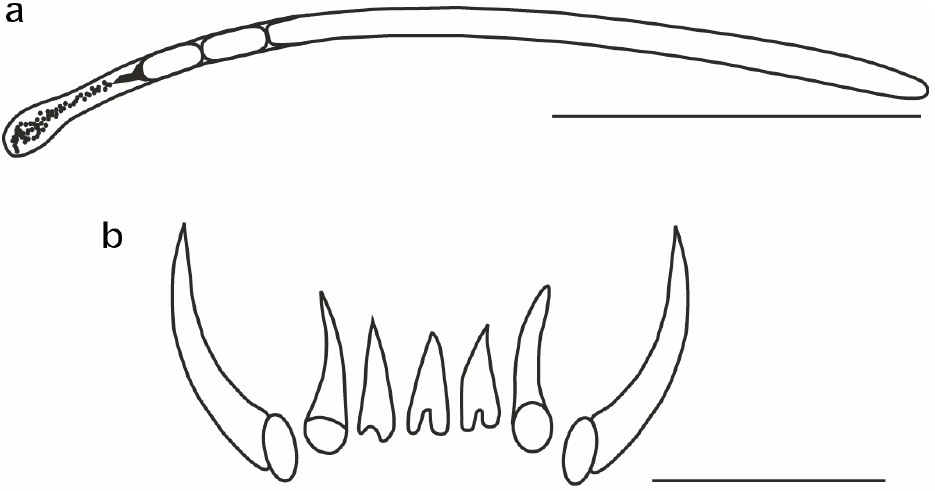
Figure 19. Sepia typica spermatophore and radula: ( a ) Spermatophore (SAIAB 211627, male ML 18 mm), scale bar 1000 μ m; ( b ) Radula (SAIAB 211655, male ML 21 mm), scale bar 500 μ m.